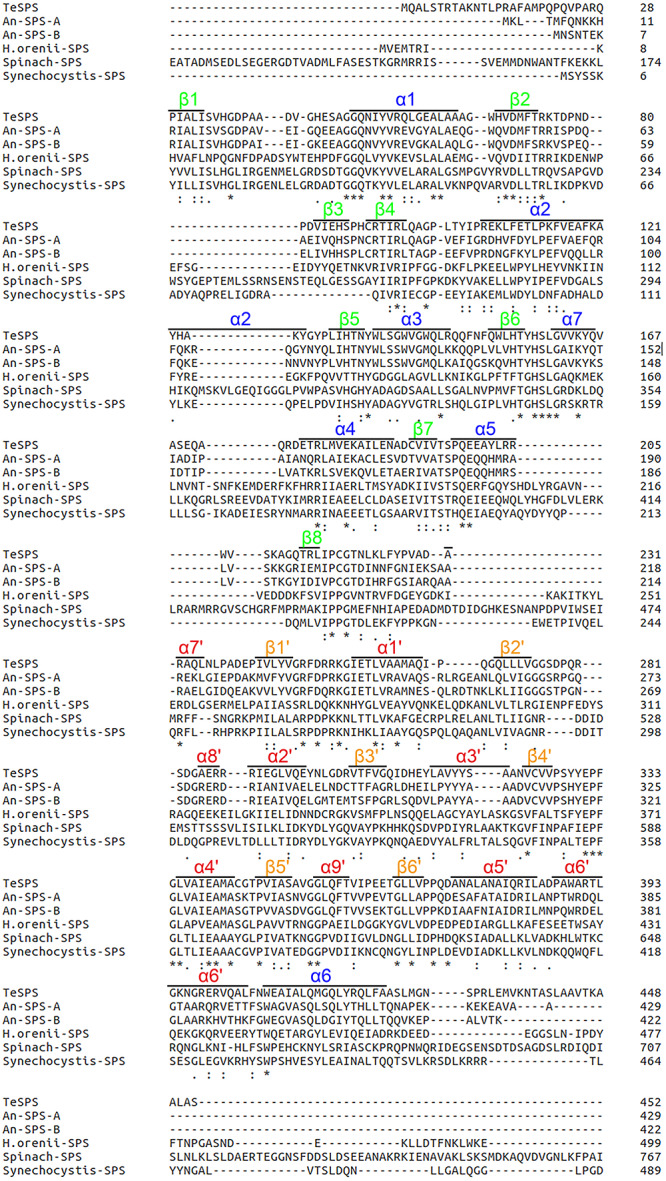
Amino acid sequence comparisons. The amino acid sequence of TeSPS is aligned with those of An-SPS-A, An-SPS-B (Cumino et al., 2002), H. orenil-SPS (Chua et al., 2008), spinach-SPS (Amir and Preiss, 1982), and Synechocystis-SPS (Curatti et al., 1998). TeSPS is highly similar to An-SPS-A and An-SPS-B. Residues within quotes “.” indicates highly conserved residues, “:” indicates those that are more conserved than “.”, and residues with “*” indicate those that are most conserved.